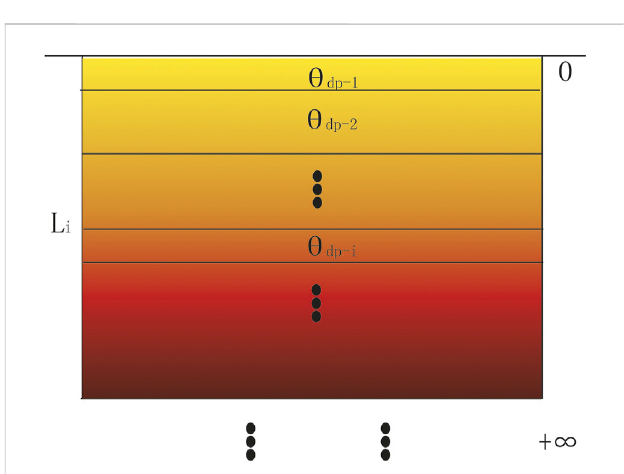
FIGURE 5 Model of the strike-slip fault with a depth-dependent θ